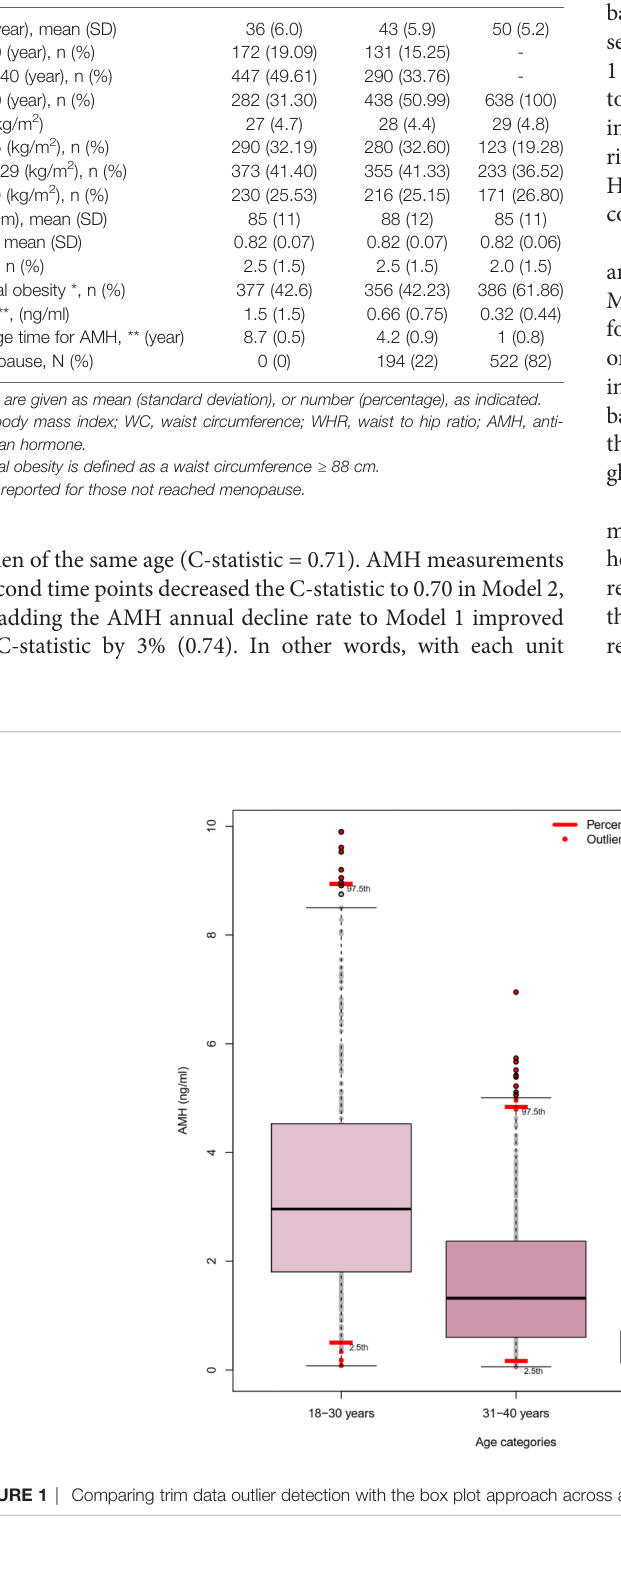
Baseline Third Sixth follow-up